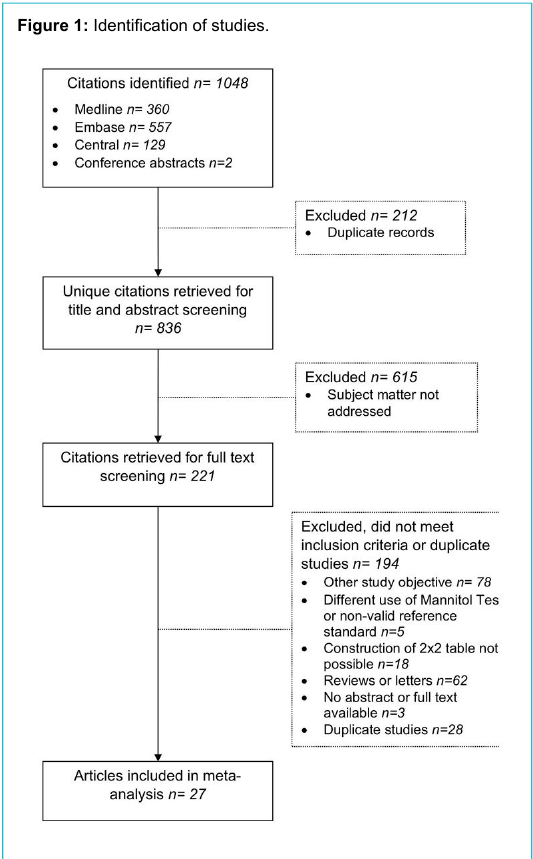
Figure 1: Identification of